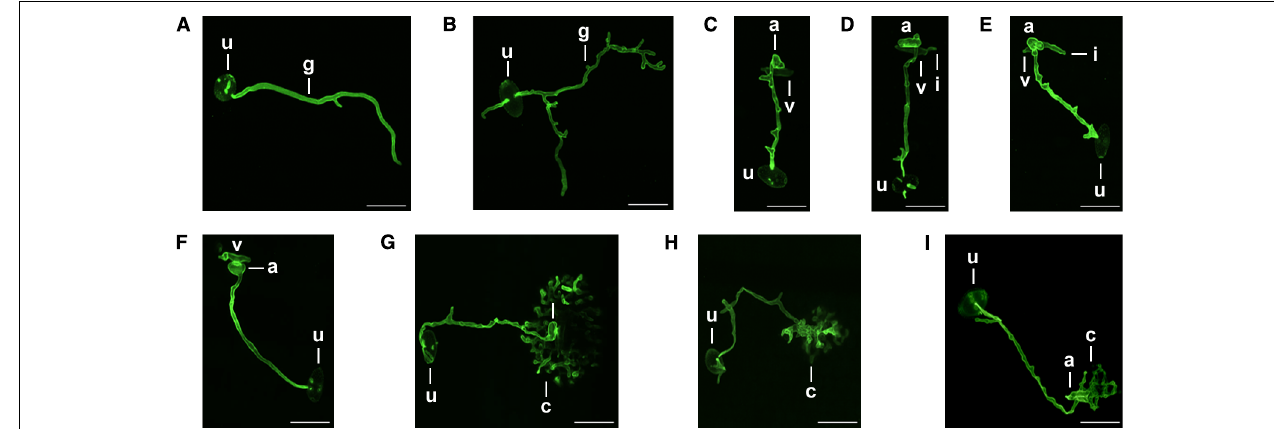
FIGURE 2 | Differentiation of morphological structures associated with the infection of P. graminis f. sp. tritici on B. distachyon . P. graminis f. sp. tritici (CRL 75-36-700-3) was used to inoculate various B. distachyon inbred lines following procedures previously reported (Figueroa et al., 2013). Fungal tissue was stained WGA-FITC as previously described (Ayliffe et al., 2013). (A,B) Germination of urediniospores (u) on the surface of leaves of B. distachyon inbred line Bd1-1, micrographs illustrate the different morphological features of germ tubes as they elongate to locate a stoma. (C–E) Differentiation of an appressorium (a) and substomatal vesicle (v) in B.